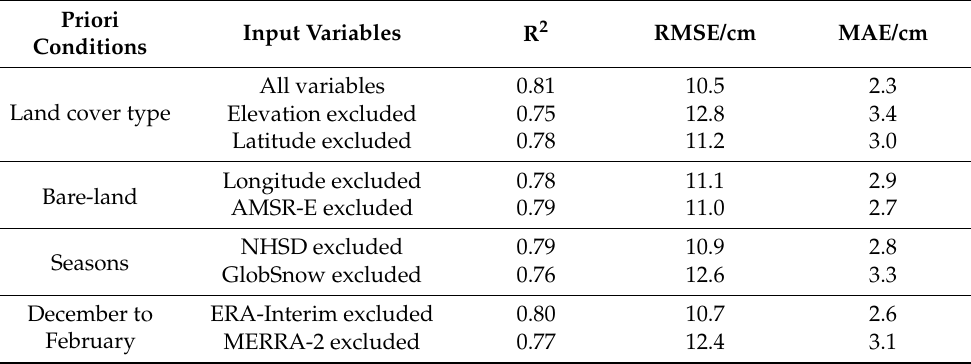
Table 4. Accuracy comparison of different input